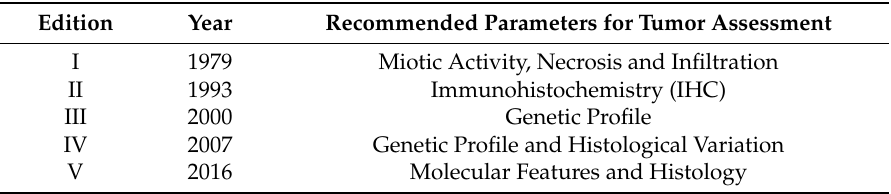
Table 2. WHO recommendations for tumor assessment in different